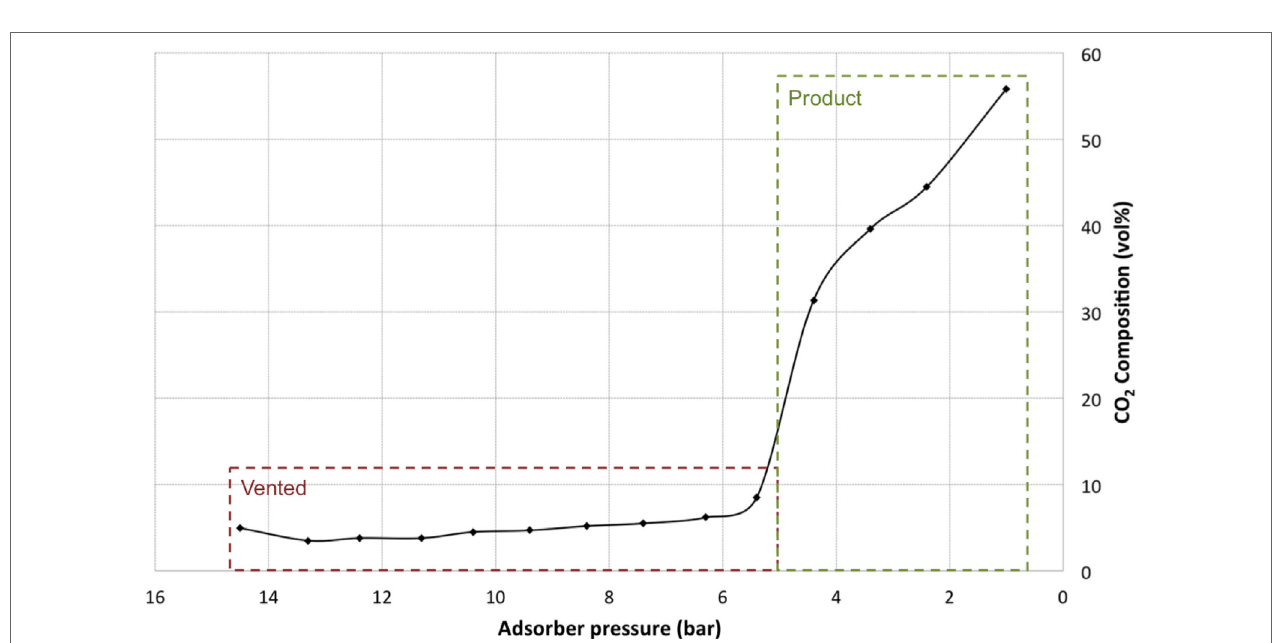
FigUre 9 | Rate of desorption for carbon dioxide and nitrogen from the sorbent over time during a single pressure drop from 15 bar down to 1